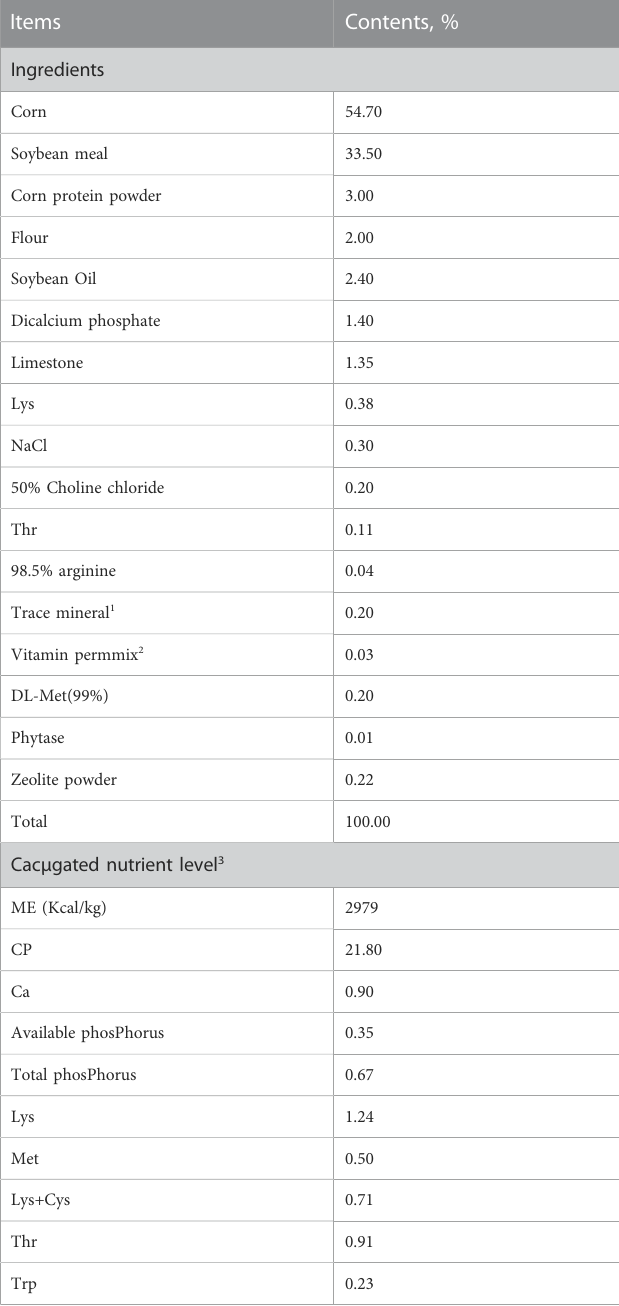
TABLE 1 Composition and nutrient levels of basal diets (air-dry